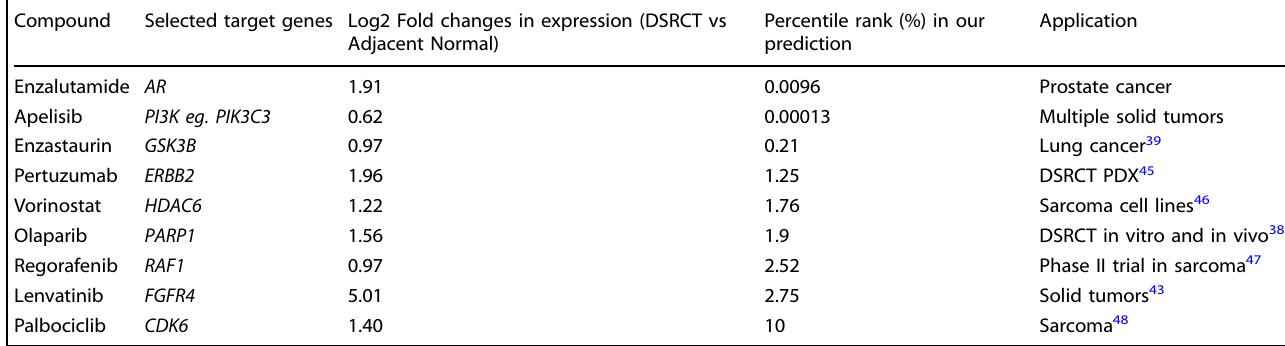
Table 3. Selected potential therapeutic targets associated with EWS-WT1 in our prediction. Compound Selected target genes Log2 Fold changes in expression (DSRCT vs Adjacent